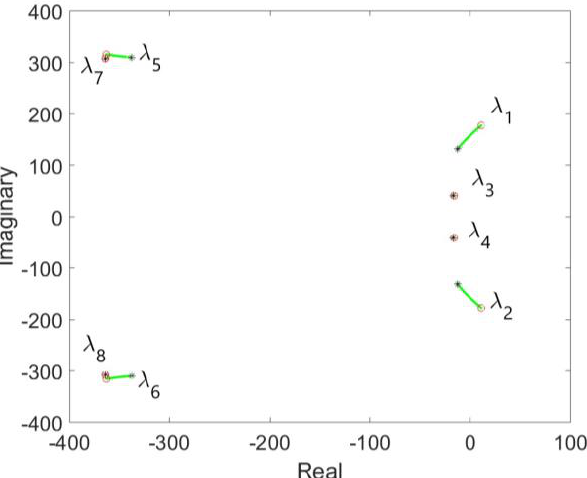
Figure 8. Eigenvalue loci of closed loop system with k p 2 from 1 to 2.